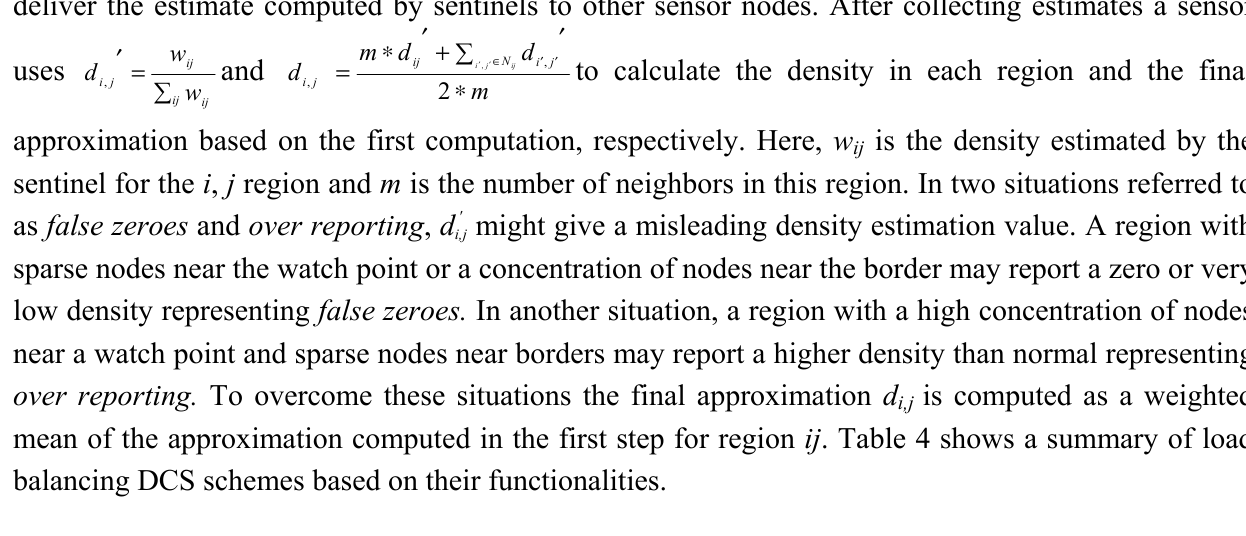
Table 4. Summary of Load Balancing DCS